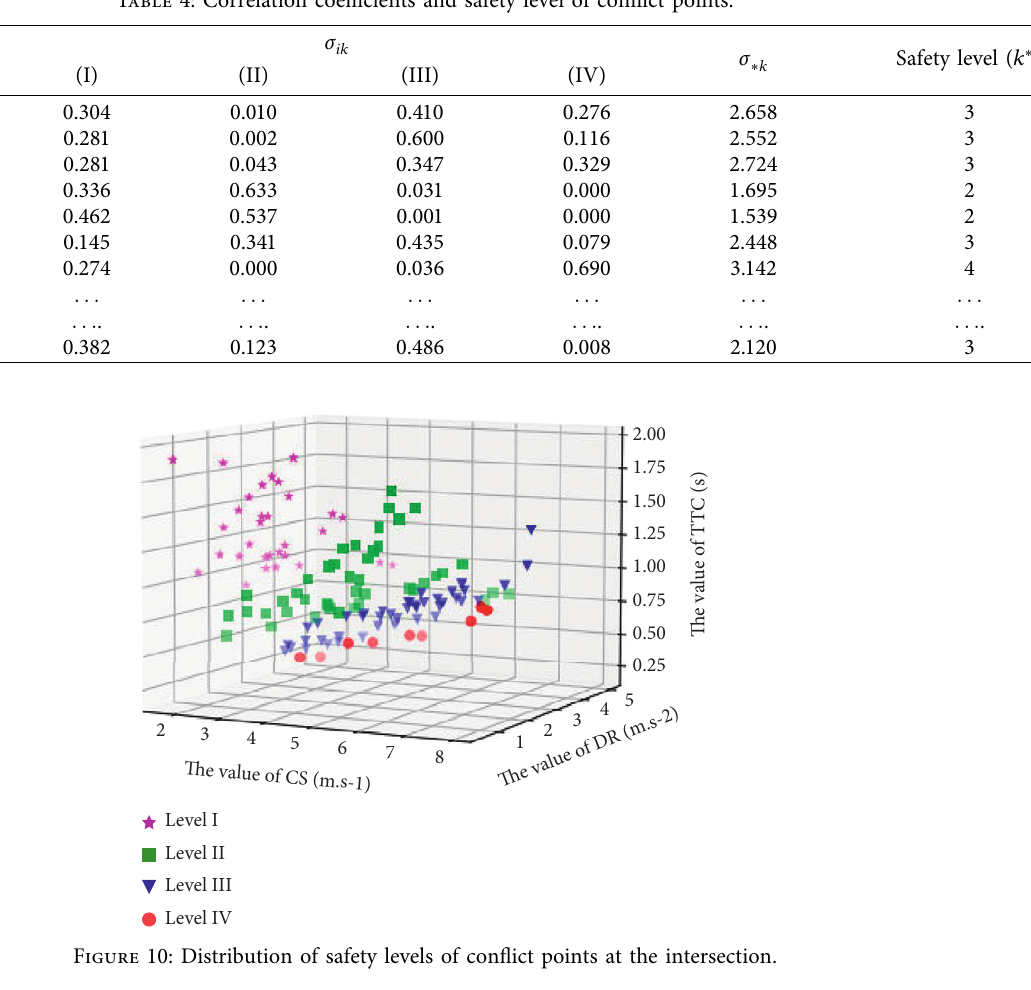
Table 4: Correlation coefficients and safety level of conflict points.